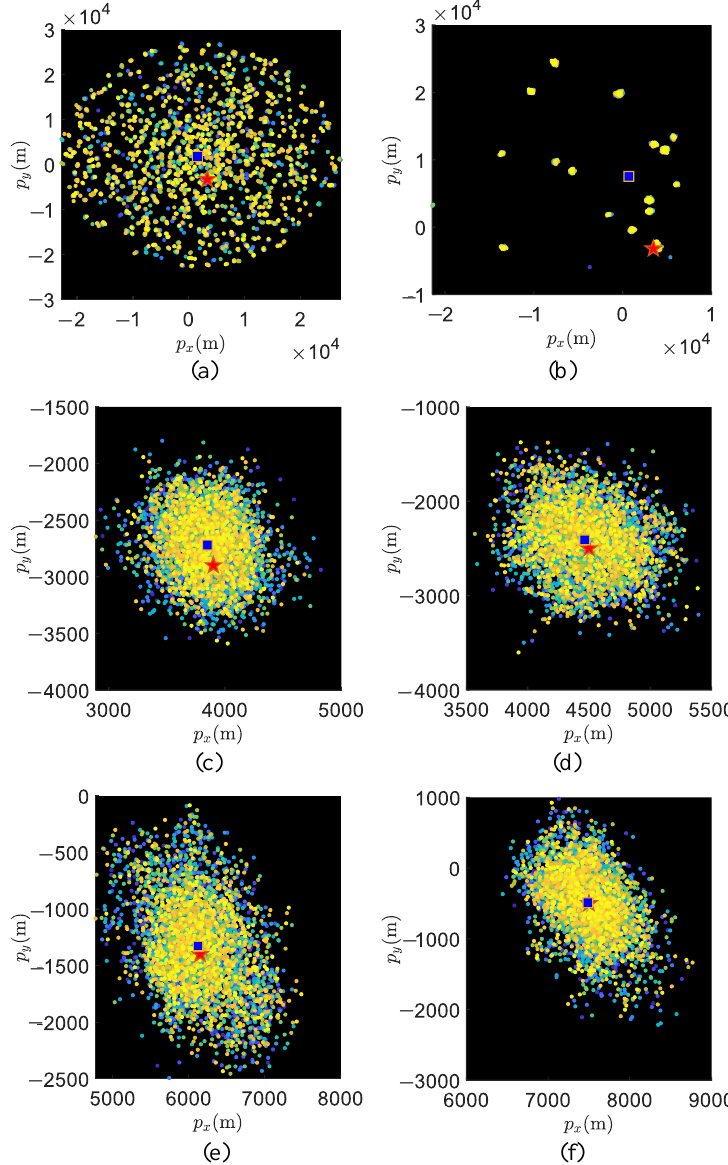
Figure 8. The positions of particles representing the posterior density at different measurement times, and the real and estimated positions of the target are represented by red stars and blue squares, respectively: ( a ) k = 2; ( b ) k = 3; ( c ) k = 6; ( d ) k = 10; ( e ) k = 20; ( f ) k =